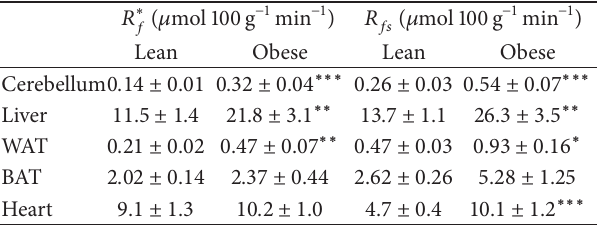
Table 4: Indices of FA utilization ( 𝑅 ∗ 𝑓 ) and FA incorporation into storage ( 𝑅 𝑓𝑠 ) in individual tissues of lean and obese Zucker rats in vivo .